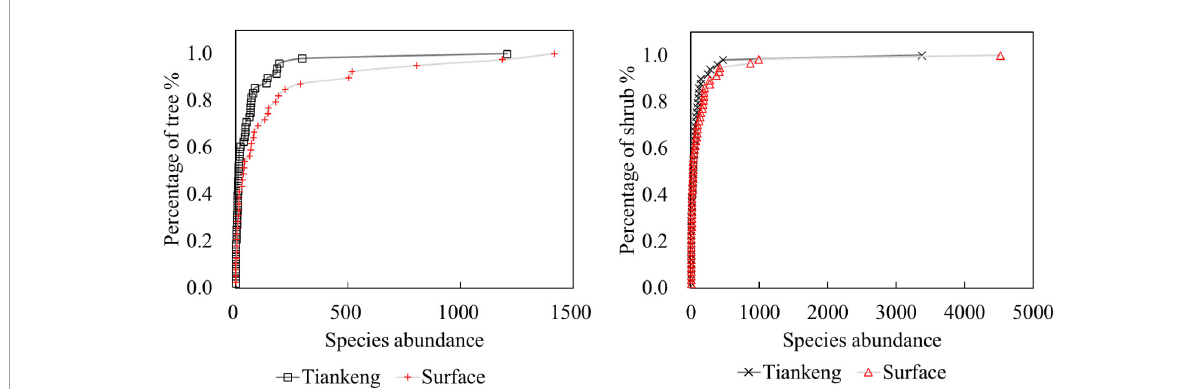
FIGURE3 Empirical cumulative distribution function (ECDF) of species within and outside the degraded karst tiankeng forest communities.